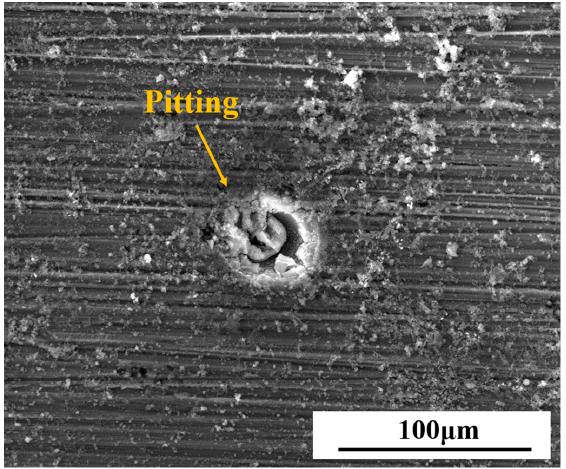
Figure 11. SEM images of corrosion morphology of uncoated 5083 aluminum alloy after 30 days immersion in 3.5% NaCl solution.